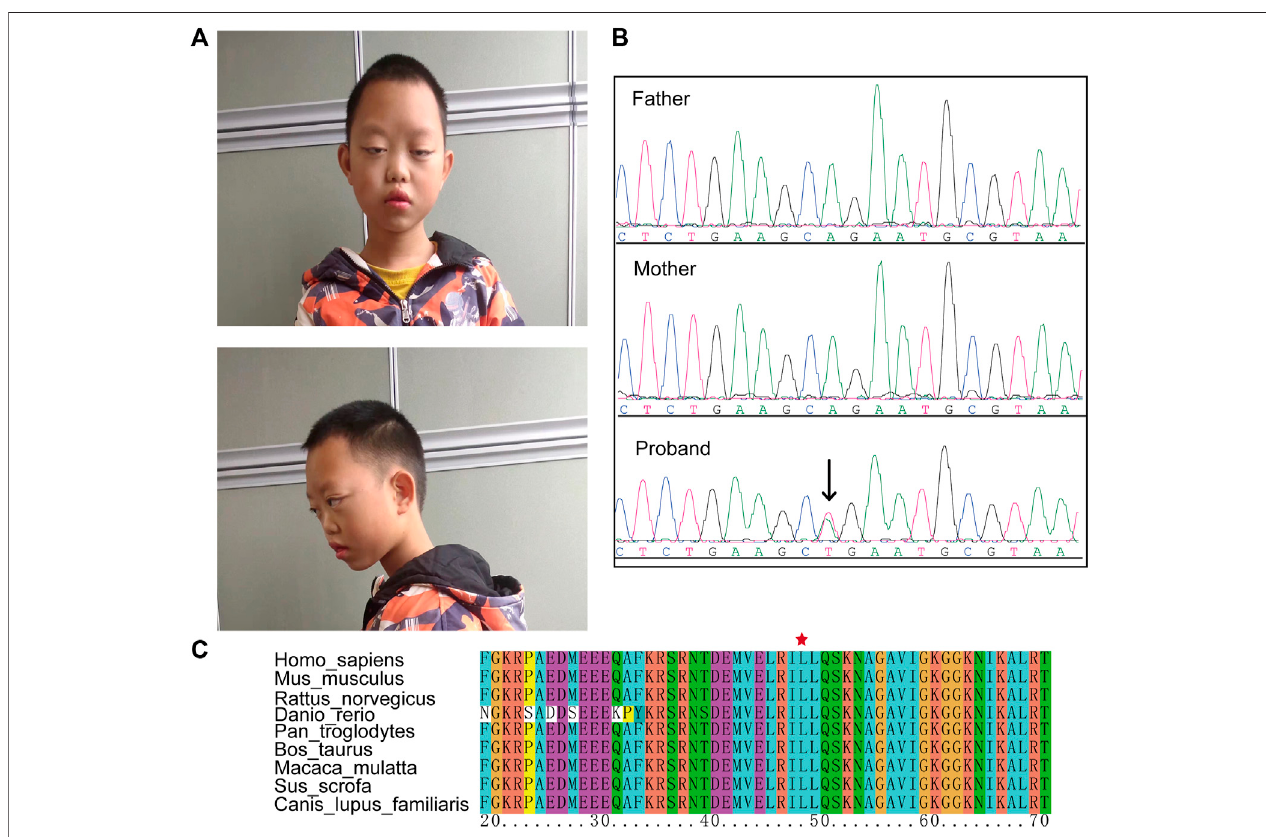
FIGURE1 | Theclinical phenotype of thecase. (A) Dysmorphicfeatures including along face, long palpebral fi ssures, ptosis, and hypoplastic alar nasi. (B) Sanger sequencing con fi rmed a de novo HNRNPK variant (NM_002140.3: c.143T > A) in the proband. (C) This variant caused an amino acid change (p. L48G) that in a highly conserved